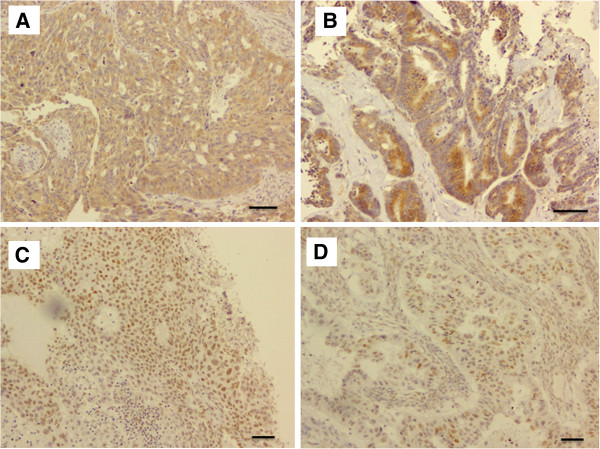
Representative examples of immunohistochemically-stained sections. Representative examples of immunohistochemically-stained sections from tumor specimens that were positive for GPR30 (A), EGFR (B), ERα (C) and ERβ (D). Scale bars represent 100 μm.